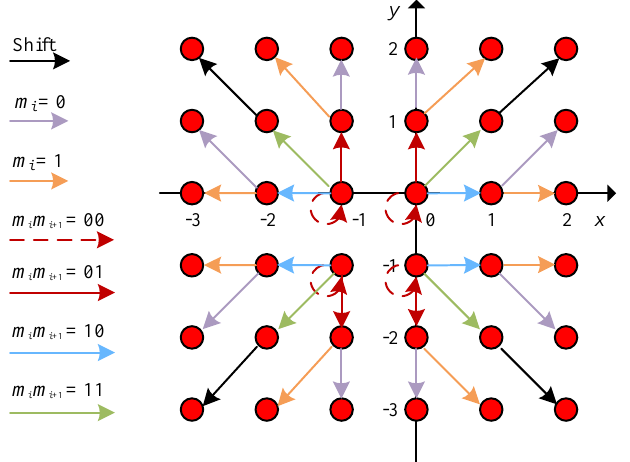
Figure 2. Classic 2D HS-based